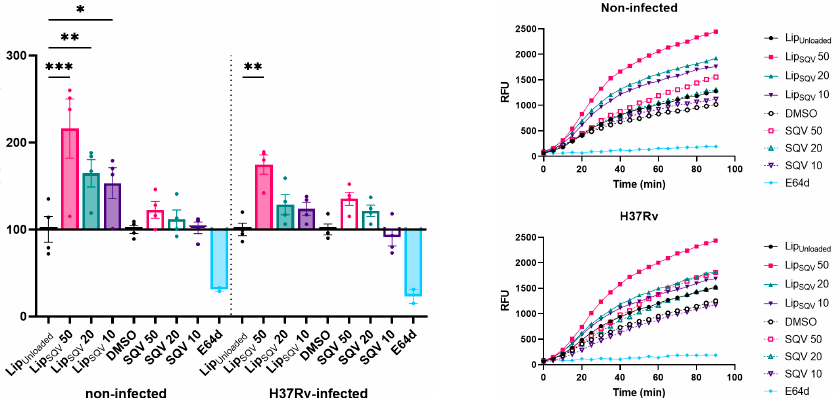
Figure 3. SQV-loaded liposomes increase the proteolytic activity of cathepsins in Mtb-infected human macrophages. Mtb-infected macrophages were treated for 3 h, then washed and incubated without drugs for an additional 24 h. Following that period, the general activity of cathepsins was monitored using a fluorogenic substrate and measured every 5 min for 90 min. General inhibitor of cathepsins, E-64d, was used as a negative control. Bars represent average baseline activity of four independent experiments. The symbols represent each donor tested and the error bars depict the standard error of the mean. Baseline activity was calculated as the maximum slope of fluorescence emission over 1 h. LipUnloaded and DMSO were used as references for LipSQV and free SQV treat- ments, respectively. Line plots display average fluorescence per time. * p ≤ 0.05, ** p ≤ 0.01, *** p ≤ 0.001. RFU—relative fluorescence units.